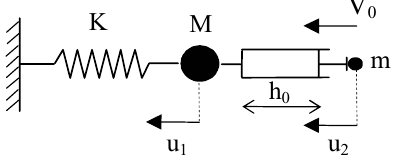
Fig. 6. Two degree of freedom model of collision between the ship and the